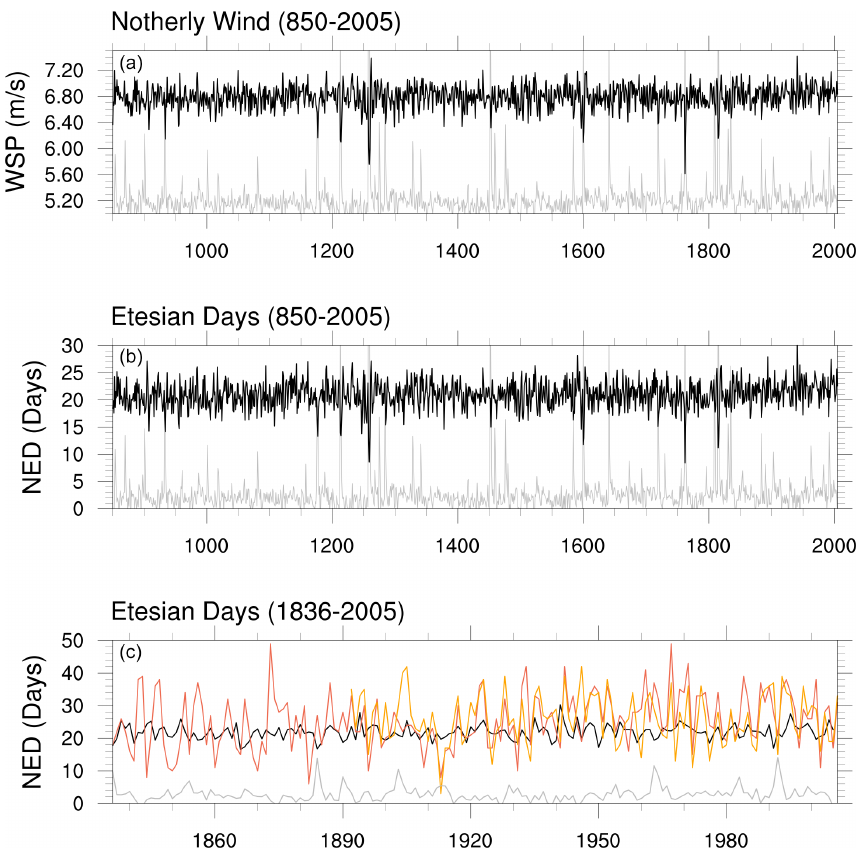
Figure 2. Time series of the JA northerly WSP (ms − 1 ) and NED (days) over the last millennium (850–2005) for CESM-LME (black), 20CR (red) and L-days (orange). (a) CESM-LME ensemble-mean WSP time series. (b) CESM-LME ensemble-mean NED time series. (c) NED time series over the common period 1836–2005 for CESM-LME, 20CR and L-days. Note the different range between panels (b) and (c) . The outgoing clear-sky SW radiation at the top of the atmosphere, averaged over the Northern Hemisphere (0–90 ◦ N, grey lines, relative scaling), is used here as a proxy for stratospheric aerosol loading, with peaks indicating volcanic